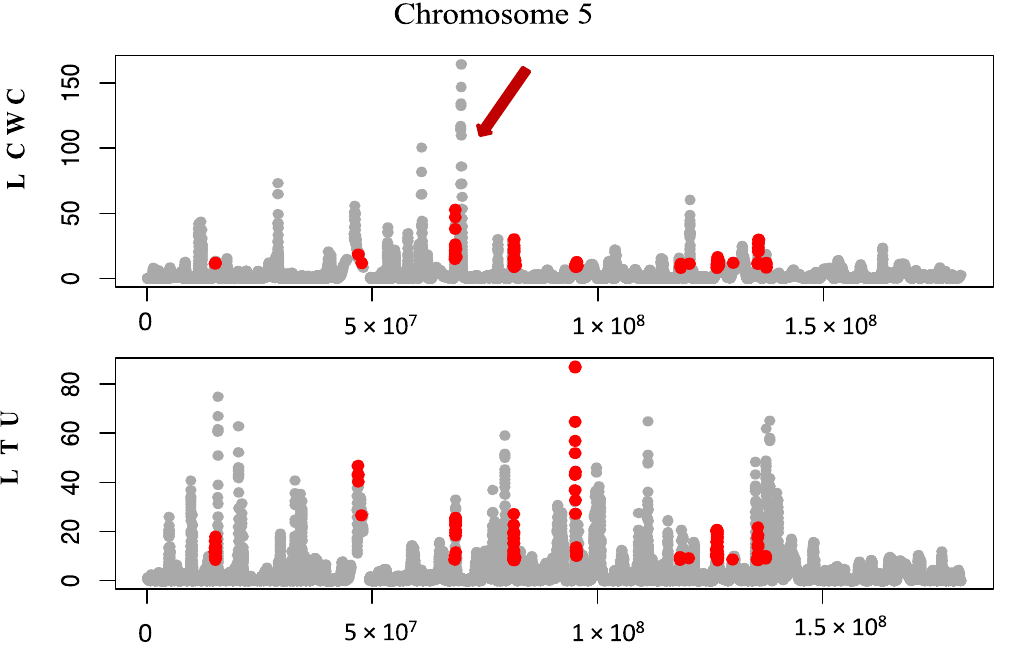
Figure 1. Analysis of the loci under positive selection on chromosome 5. The cohorts of the Lithuanian clean-up workers of the Chornobyl nuclear disaster (LCWC) and the general Lithuanian population (LTU) were compared. X -axis—genomic position; Y axis—positive selection signature µ value. The unique positive selection loci are marked grey, and the common ones are marked red. An arrow depicts the positive selection locus unique to LCWC, which has the highest µ value. The results of the analysis of positive natural selection for other chromosomes are provided in Supplementary Figure S1.